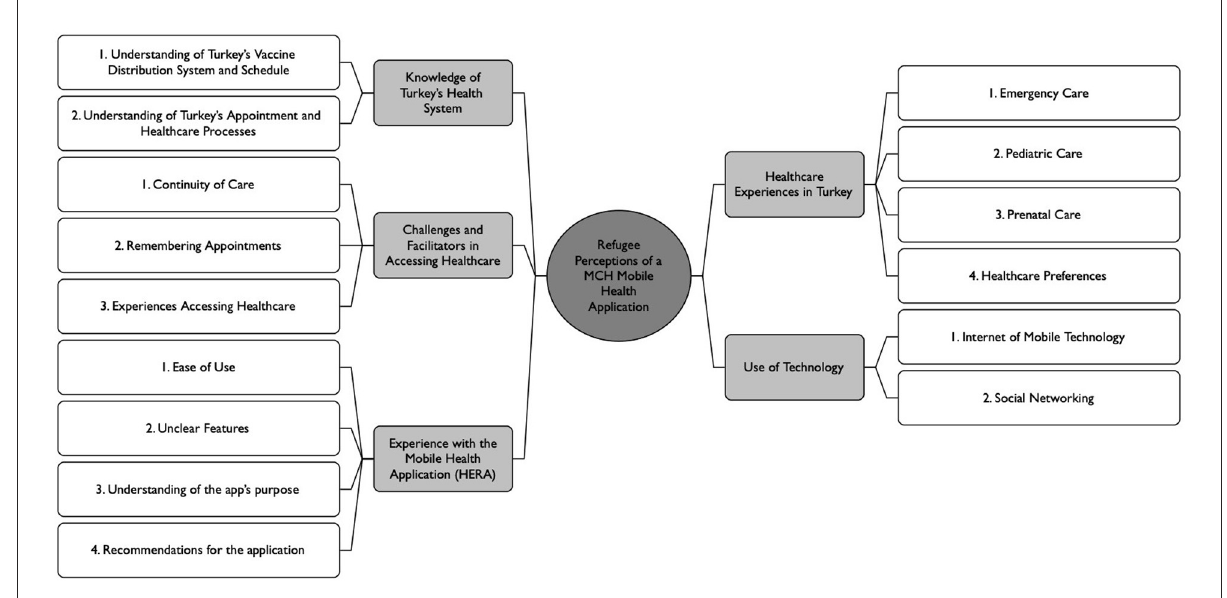
FIGURE1 Coding tree diagram with themes and sub-themes.